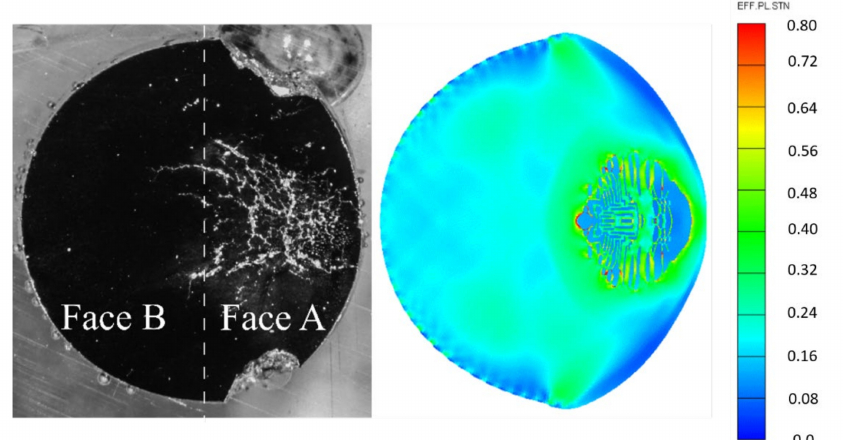
Figure 8. Photograph of the sectioned ball bearing from a 5.13 g detonation ( left ) and the simulated effective plastic strain contour 2.5 µ s after detonation ( right